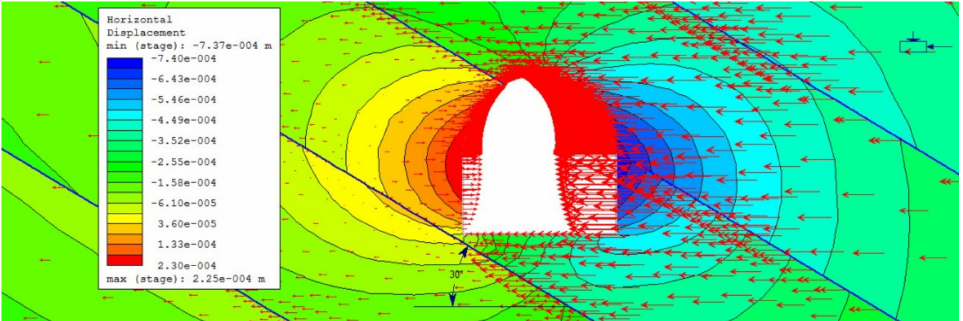
Figure 5. Vectors of horizontal displacement contours of rock after tunnel opening has been intro- duced at in situ stress ratio, K, of